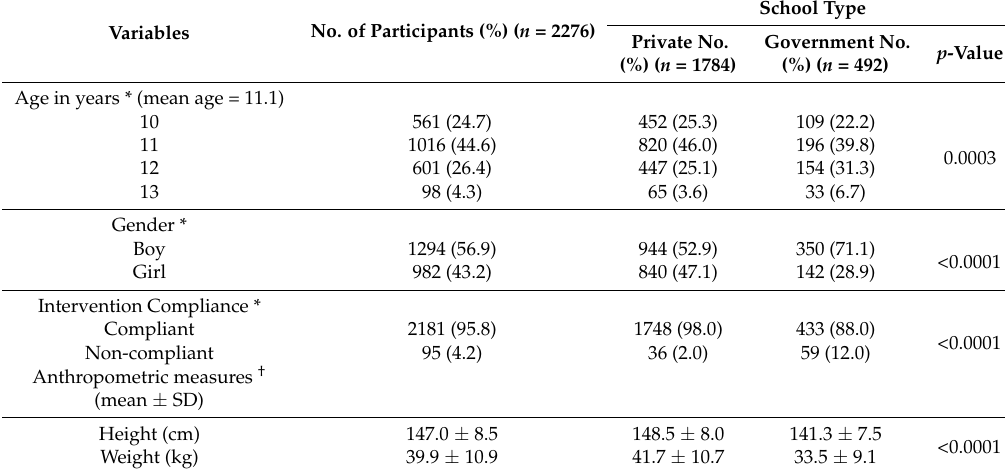
Table 1. Characteristics of the Obesity Reduction and Awareness of Non-communicable disease through Group Education (ORANGE) study participants by school